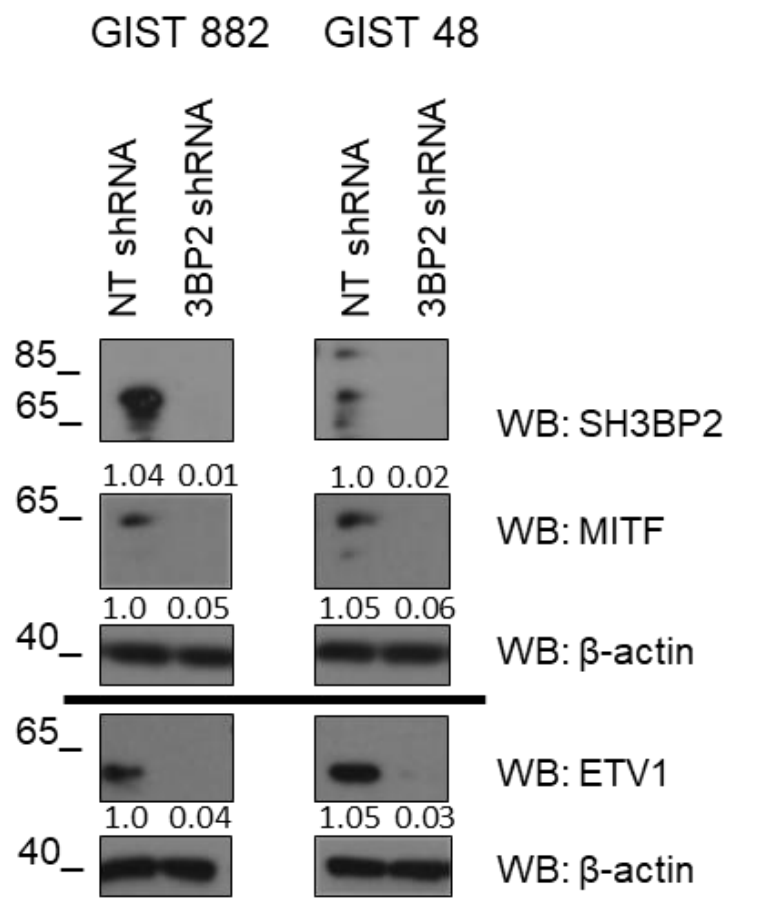
Figure 1. Reduced levels of ETV1 and MITF in SH3BP2-silenced GIST cells. GIST882 and GIST48 were transduced with control NT (Non-target) shRNA and SH3BP2 shRNA. Cell lysates were ana- lyzed on the 7th day post- transduction for MITF, ETV1, and SH3BP2. β -actin was used as a loading